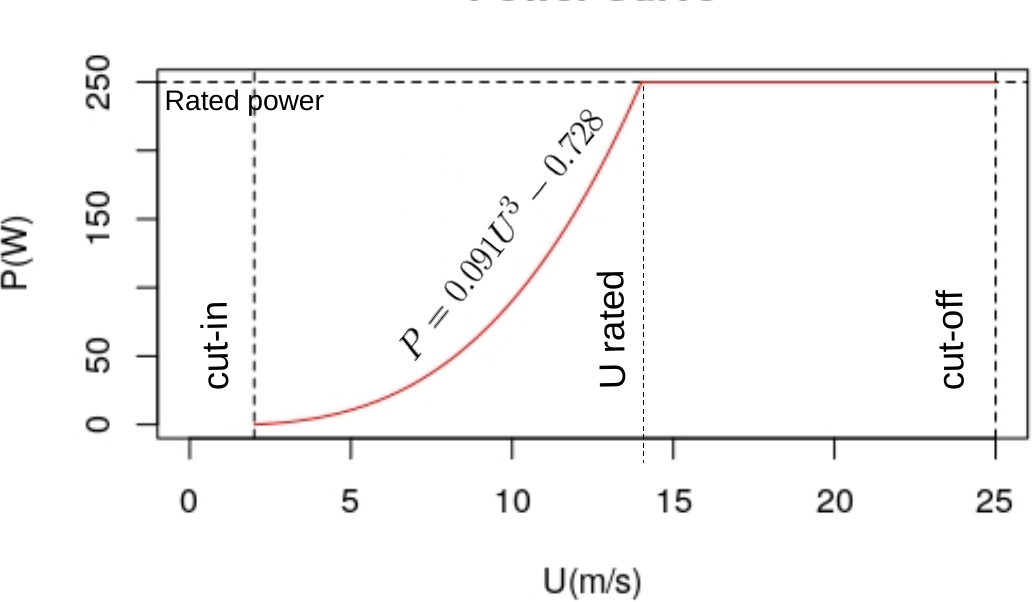
Figure 9. Estimated power curve of the Savonious drag-type turbine for a 250 W generator without guiding vanes or plates.